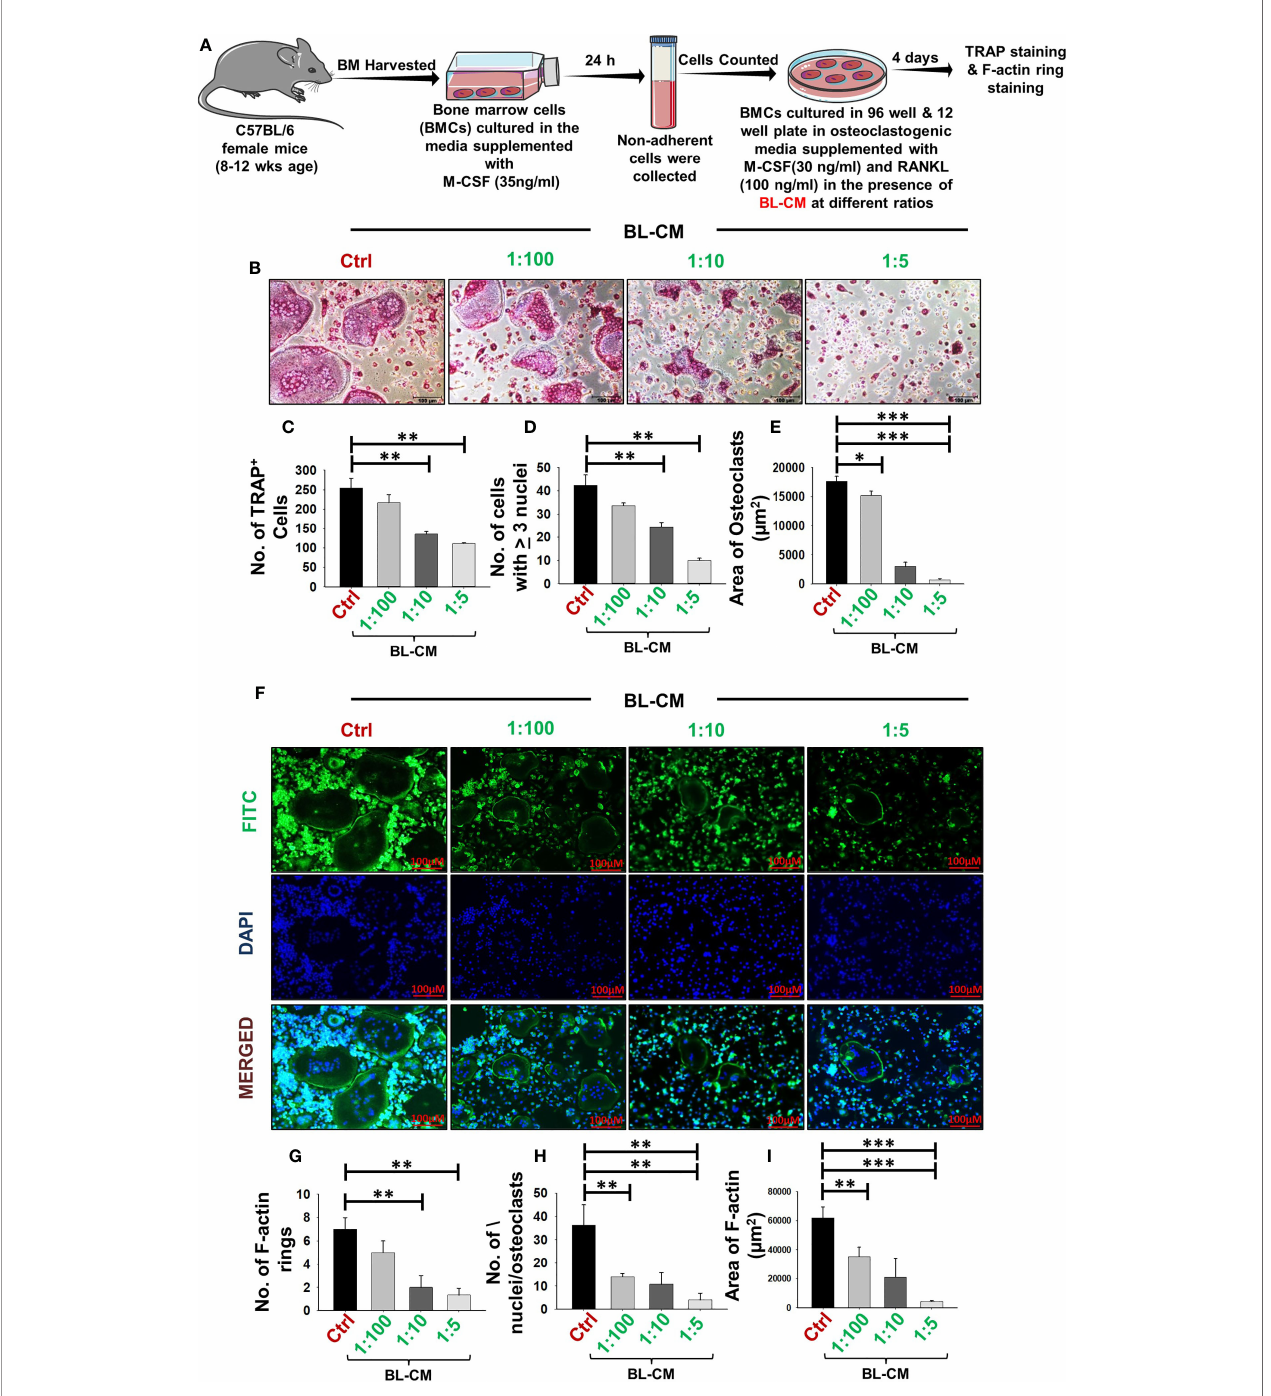
FIGURE 1 | BL suppress osteoclastogenesis and F-actin polymerization in a dose-dependent manner: (A) Osteoclast differentiation was induced in bone marrow cells (BMCs) with M-CSF (30 ng/ml) and RANKL (100 ng/ml) with or without Bi fi dobacterium longum -conditioned media (BL-CM) at different ratios of 1:100, 1:10, and 1:5 for 4 days. Giant multinucleated cells were stained with TRAP, and cells with ≥ 3 nuclei were considered as mature osteoclasts. (B) Photomicrographs at ×20 magni fi cation were taken. (C) Number of TRAP-positive cells. (D) Number of TRAP-positive cells with more than 3 nuclei. (E) Area of osteoclasts. (F) F-Actin and nuclei were stained with FITC-conjugated phalloidin and DAPI, respectively. Images were captured in a fl uorescence microscope (Imager.Z2 Zeiss microscope) at ×10 magni fi cation. (G) Number of F-actin rings. (H) Number of nuclei per osteoclasts. (I) Area of the F-actin ring. The above images are indicative of one independent experiment, and similar results were obtained in at least three independent experiments (n ≥ 3). Statistical signi fi cance was considered as p ≤ 0.05 (*p ≤ 0.05, **p ≤ 0.01, ***p ≤ 0.001) with respect to indicated